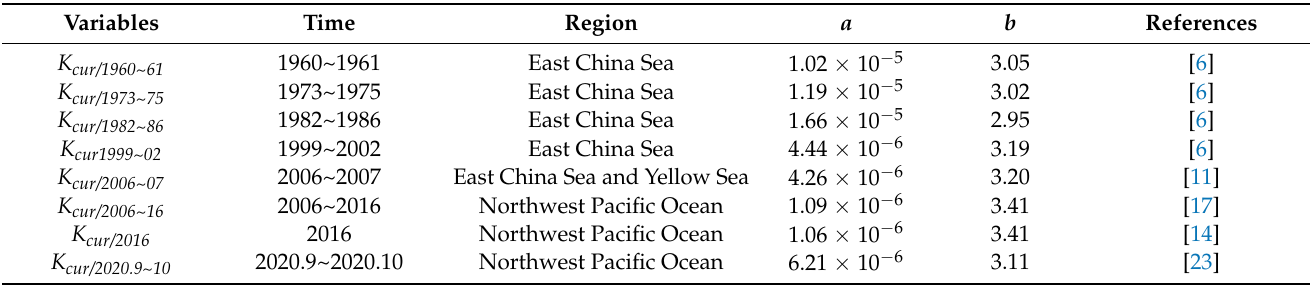
Table 3. Summary of the Length-weight relationship parameters of Chub mackerel used to estimate the condition